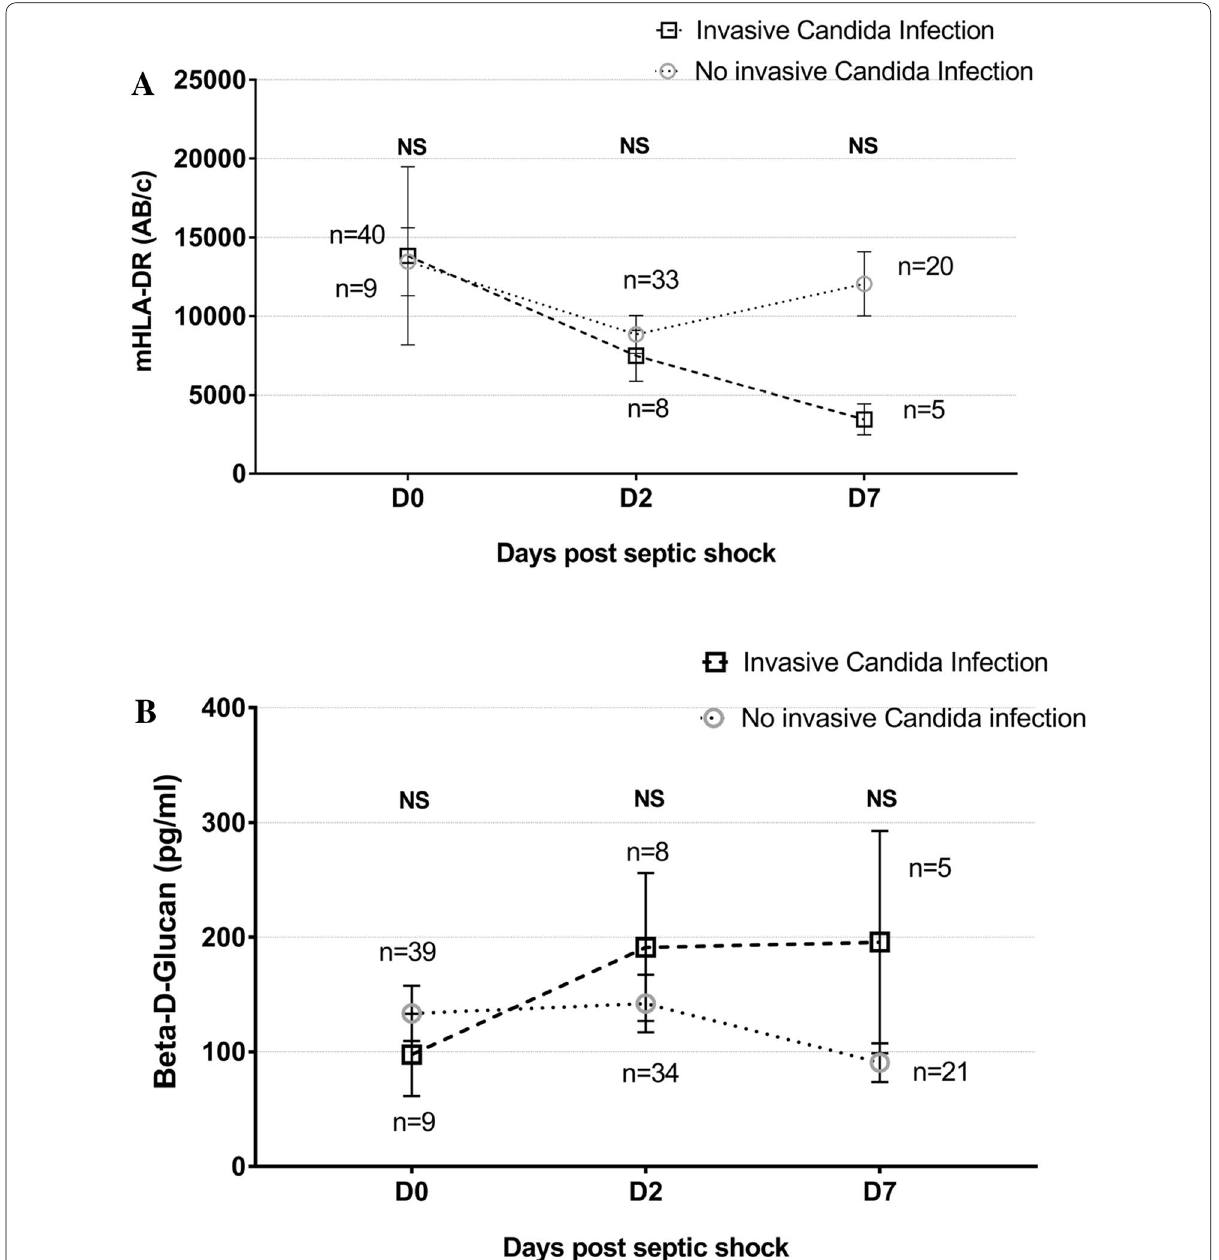
Fig. 2 A Time course of mHLA-DR from day 0 to day 7 post septic shock. Results are expressed as mean from day 0 to day 7 is not significant. However, considering day 7 and day 0, mHLA-DR was different between IC and NIC patients. B Time course of β- d -glucan from day 0 to day 7 post septic shock. Results are expressed as mean